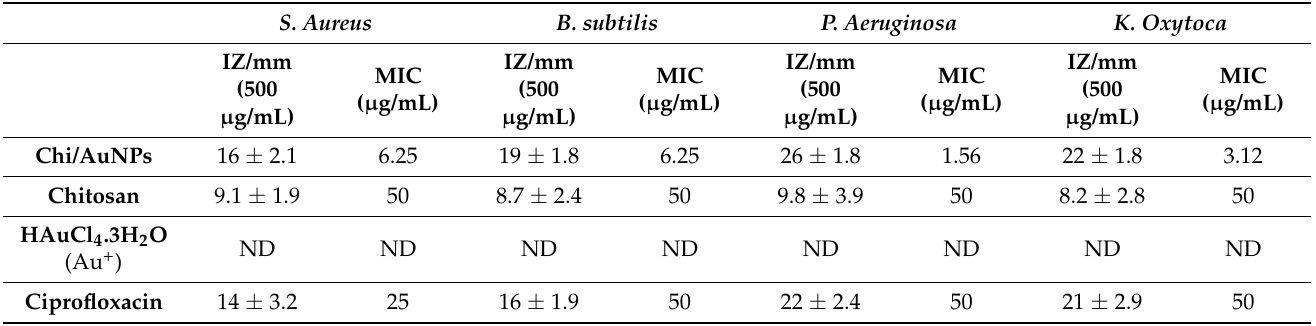
Table 1. Inhibition zones and MICs of Chi/AuNPs, chitosan, HAuCl 4 .3H 2 O, and